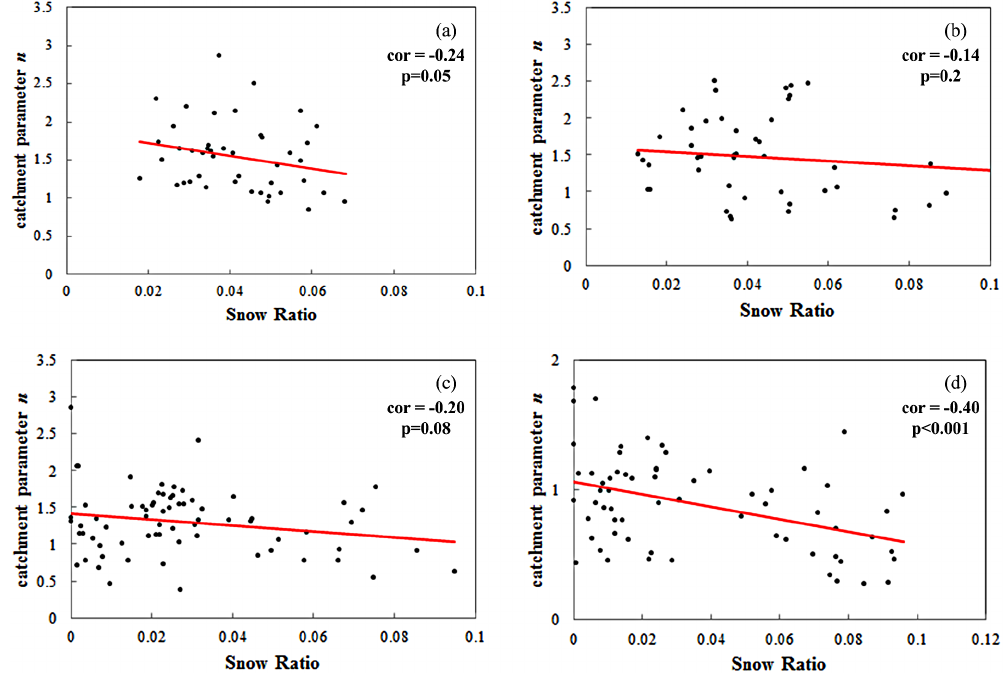
Figure 4. Similar with Fig. 3 for catchment average slope. (a–d) indicate the average slope (%) of (0.2, 3.8), (3.8, 5.5), (5.5, 8.0), and > 8.0,